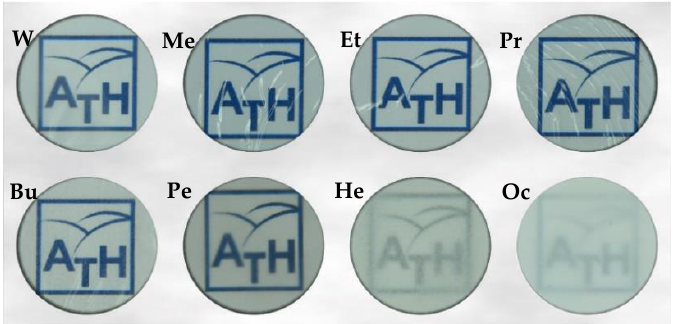
Figure 3. Images of a pure cellulose membrane coagulated in distilled water (W), methanol (Me), ethanol (Et), 1-propanol (Pr), 1-butanol (Bu), 1-pentanol (Pe), 1-hexanol (He) and 1-octanol (Oc) (our university’s logo was placed under the membranes for a better display of their transparency).